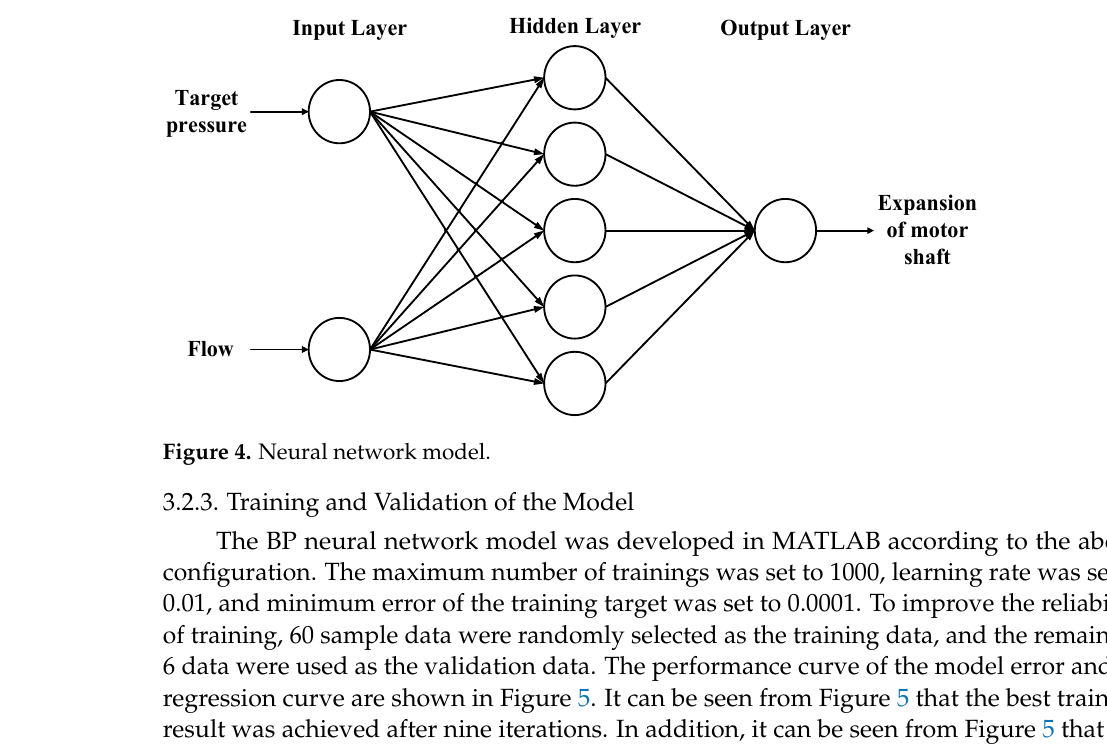
Figure 4. Neural network model.